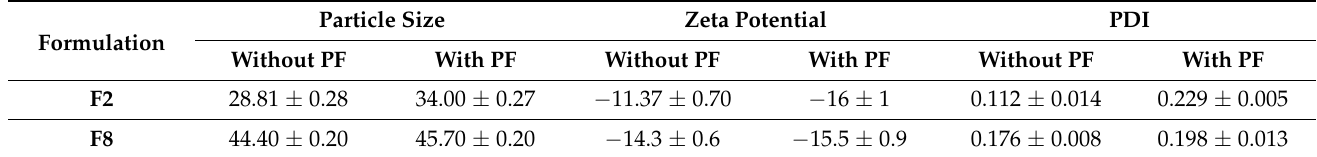
Table 6. Mean particle size, PDI, and zeta potential values of the propofol (PF)-loaded SNEDDS and PF-free SNEDDS formulations at 0 time.